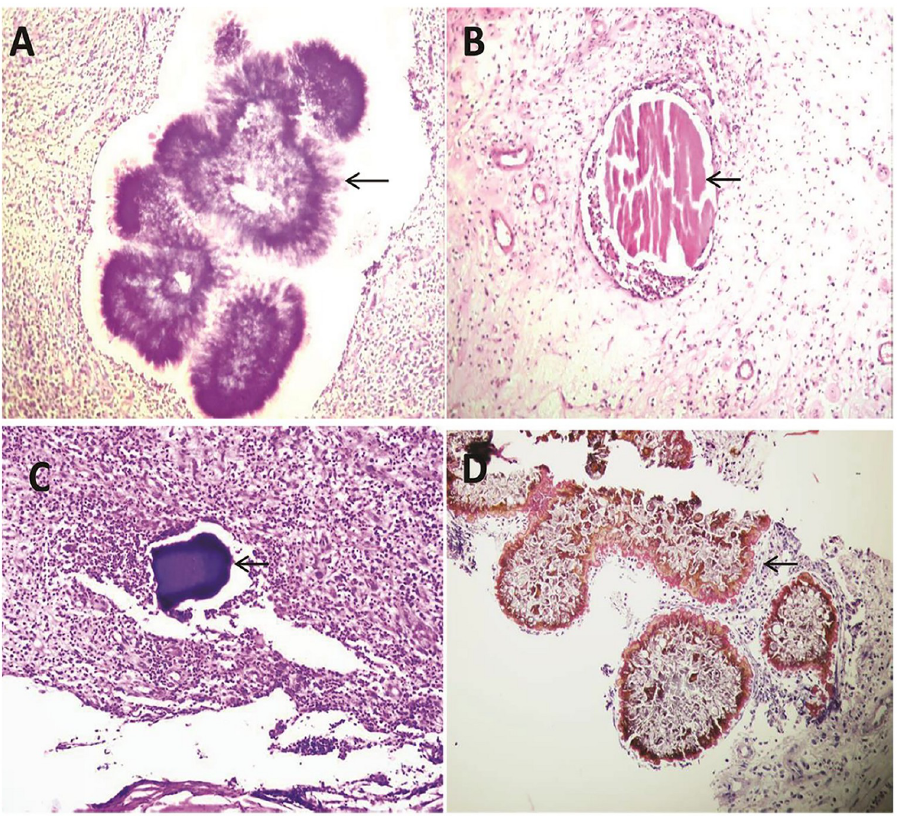
Fig 3. Histopathological appearance of mycetoma causative agents. The histopathological appearance of A . madurae (A), S . somaliensis (B), A . pelletierii (C) and M . mycetomatis (D) in HE stained sections (Magnification